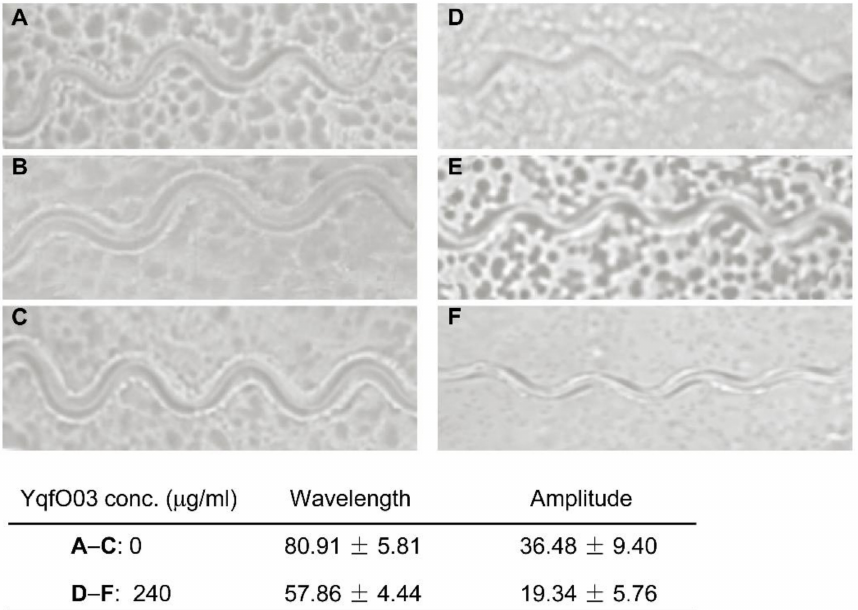
Figure 7. Effect of purified YqfO03 on C. elegans motility. In ( A – C ), track patterns of worms on S medium in the absence of YqfO03 (negative control). In ( D – F ), track patterns of worms on S medium containing 240 µ g/mL of purified YqfO03